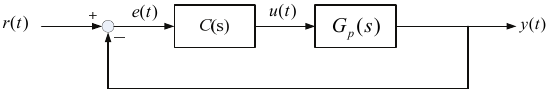
Fig.1. Closed-loop system structure of robust controller for interval